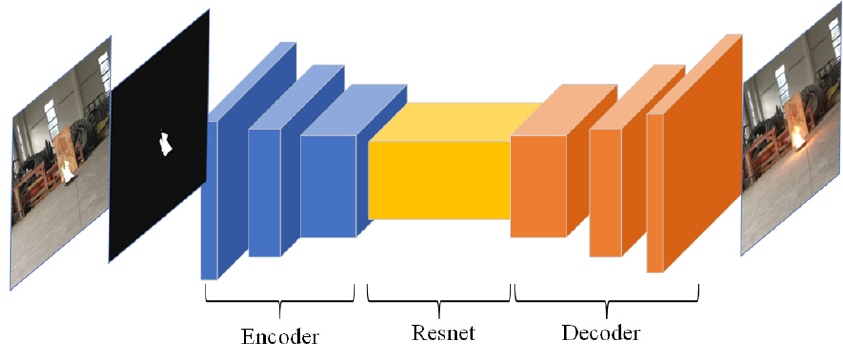
Figure 6. The generation module structure.